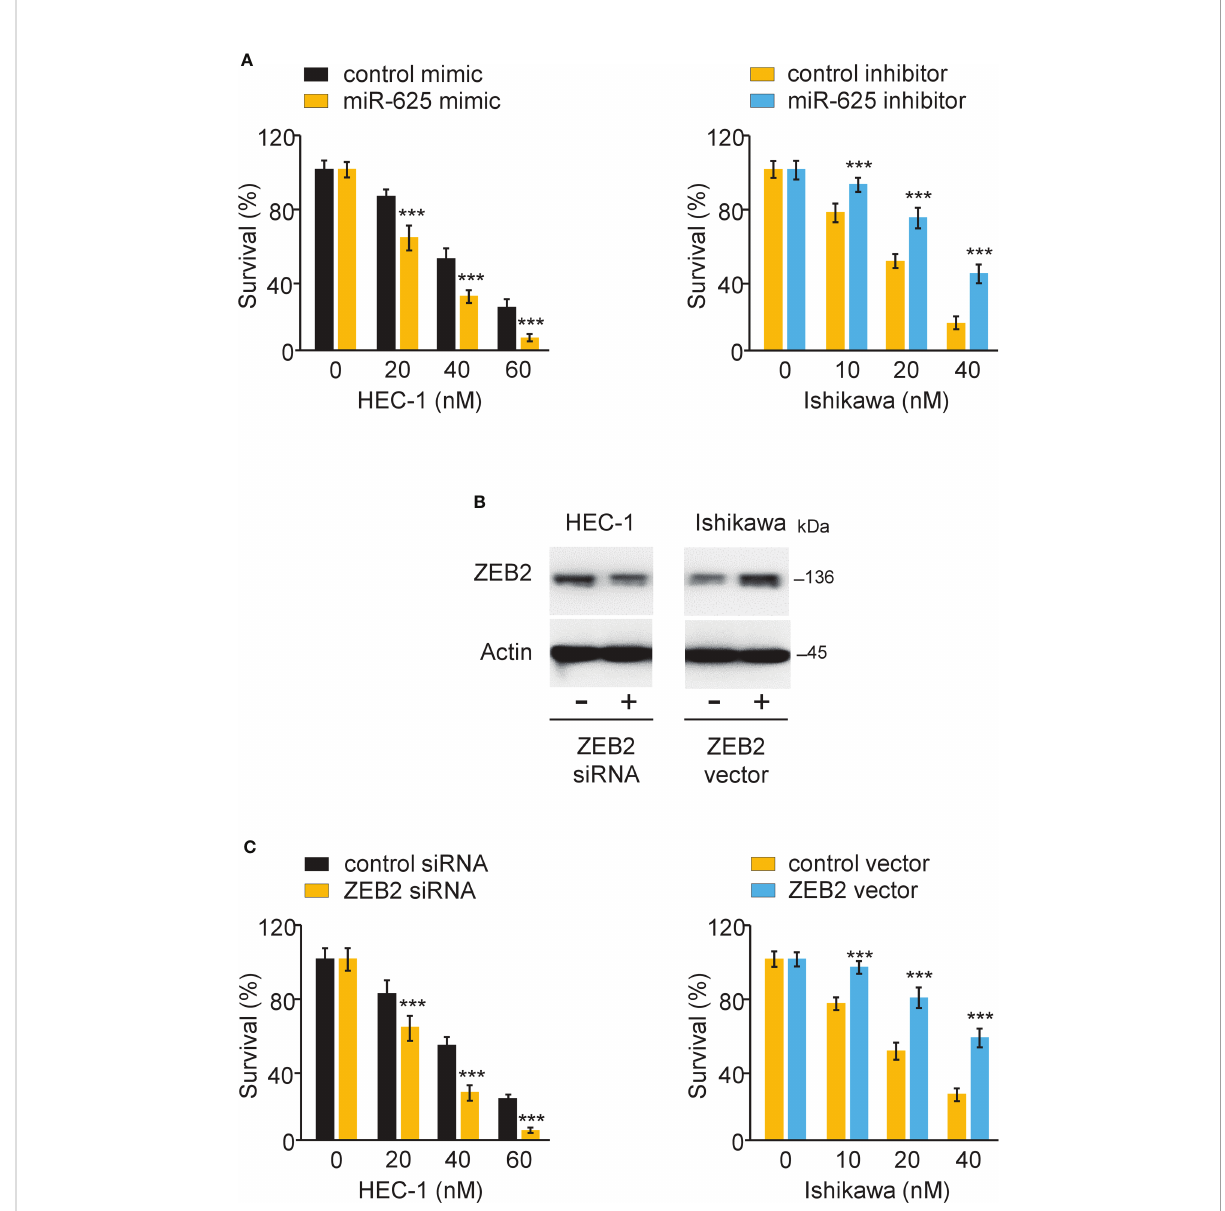
FIGURE 8 MiR-625 sensitizes the response to paclitaxel by regulating ZEB2 in endometrial cancer cells. (A) Endometrial cancer cells were transfected as indicated and treated with various concentrations of Paclitaxel, and cell viability was determined using a CCK-8 assay. (B) Western blot assay of ZEB2 and actin expression in endometrial cancer cells transfected as indicated. (C) Endometrial cancer cells were transfected as indicated and treated with various concentrations of Paclitaxel, and cell viability was determined using a CCK-8 assay. *** P <